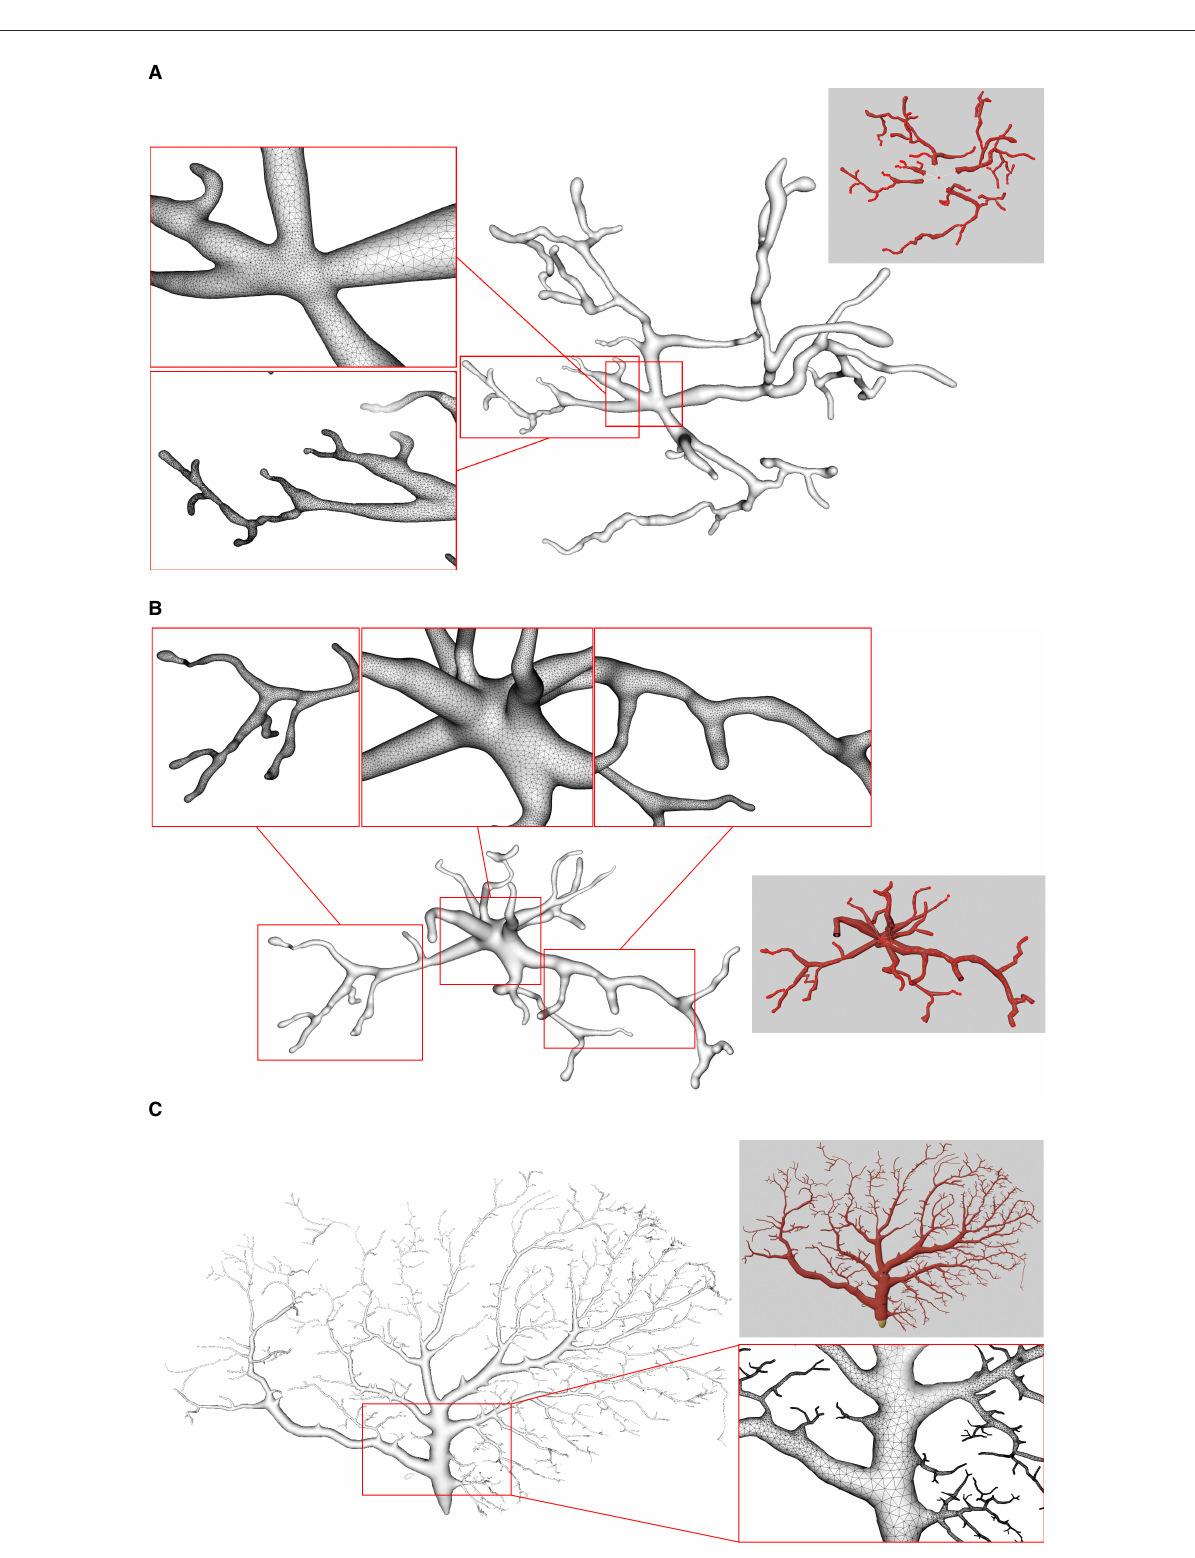
FIGURE11 Examples of three surface meshes generated by the proposed approach. Local regions on the meshes are zoomed in for the display of details. The corresponding input point-and-diameter morphology data are shown in small panels. (A) A cell of a mouse, which includes 345 nodes and 61 branches. (B) A cell of a mouse, and it is composed of 247 nodes and 46 branches. (C) A cell of a drosophila melanogaster with 3224 nodes and 1169